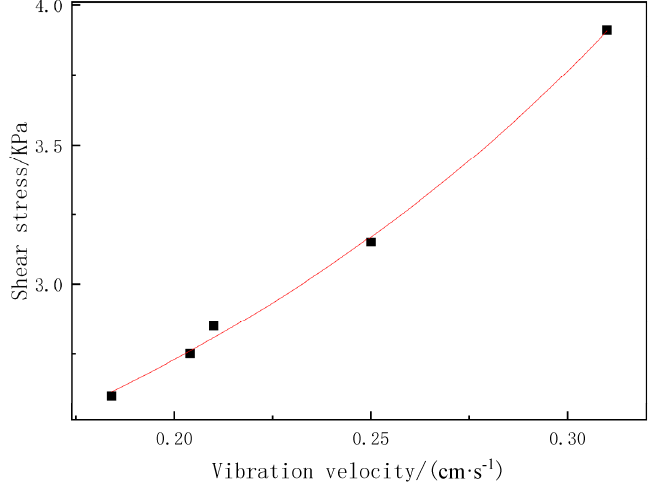
Figure 17. Horizontal radial peak shear stress versus synthetic peak vibration at an elevation of 20 m velocity.